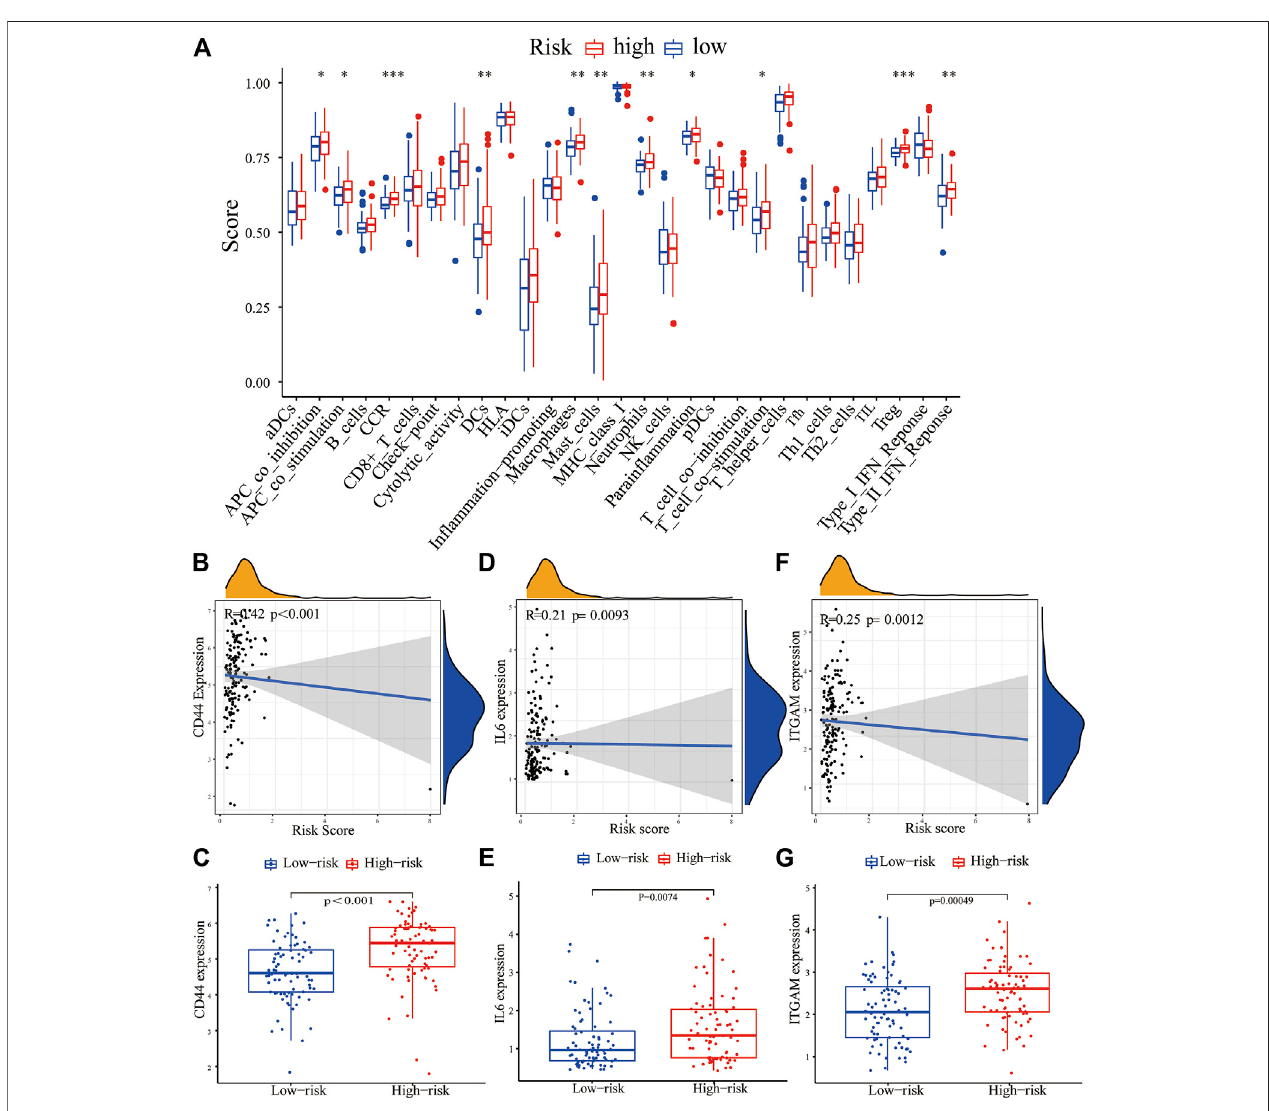
FIGURE 8 | CorrelationbetweenthePRMandtumorimmunemicroenvironmentfeatures. (A) Enrichmentscoresof16immunecellsand13immunefunctionsinthehigh- riskandlow-riskgroupsofthePRM.Thedifferentialexpressionofmostcheckpointgenes,CD44 (B,C) ,IL-6 (D,E) ,andITGAM (F,G) inthehigh-riskgroupandthelow-riskgroup.